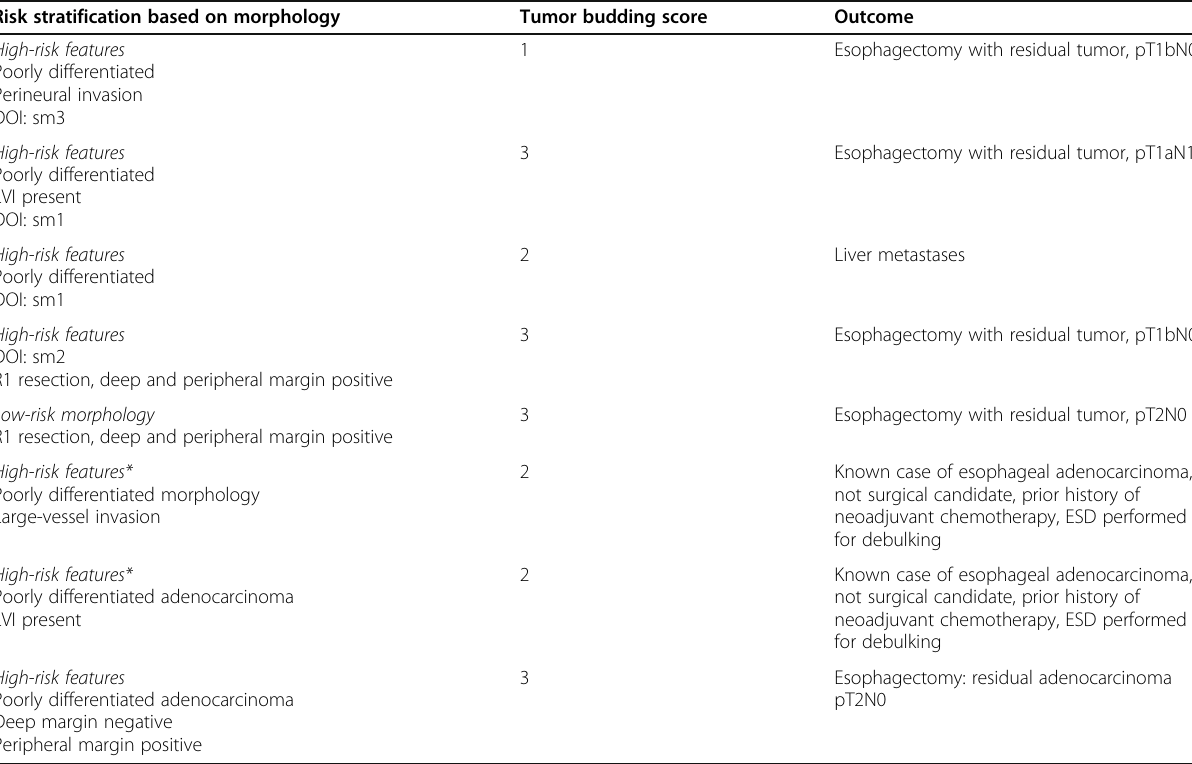
Table 6 Tumor budding and outcomes ( n = 8) Risk stratification based on morphology Tumor budding score